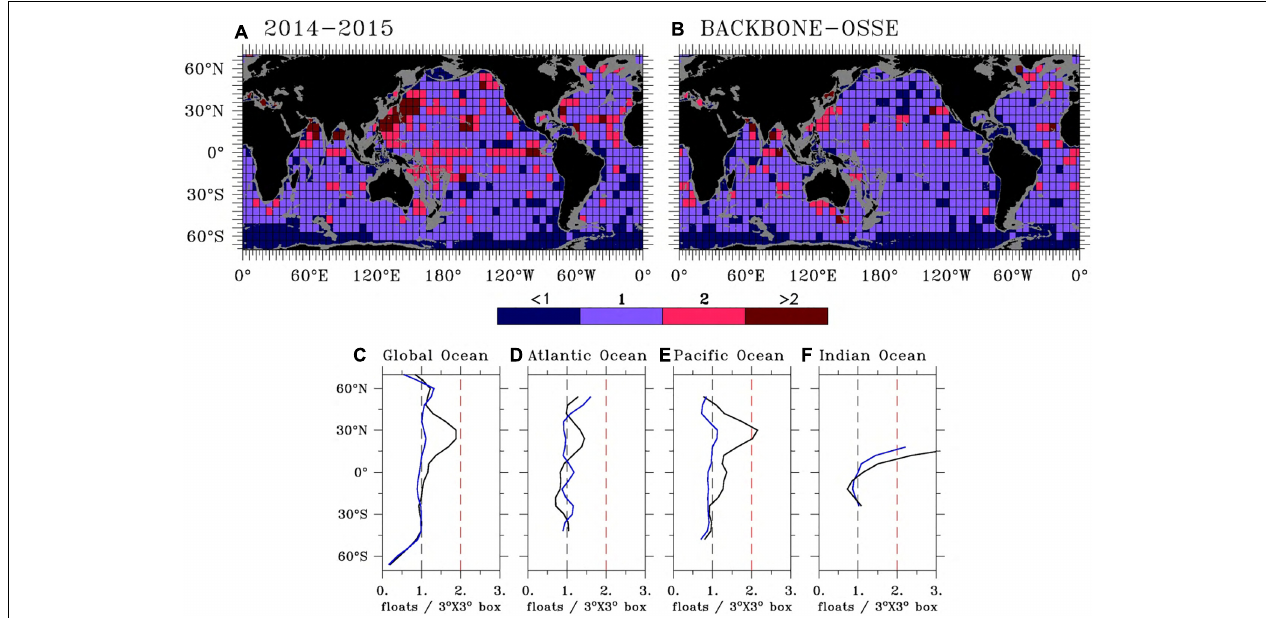
FIGURE 1 | Time-averaged number of floats per 6 ◦ × 6 ◦ box (A) from the CORA4.1 dataset for the period 2014–2015, and (B) from the synthetic BACKBONE Argo design for the period 2009–2010. Unit is equivalent float number per 3 ◦ × 3 ◦ box. In (C–F) , the zonally averaged number of floats is indicated for each basin, with (C) the global Ocean, (D) the Atlantic Ocean, (E) the Pacific Ocean, and (F) the Indian Ocean. The black and blue lines indicate the 2014–2015 CORA4.1 and the 2009–2010 synthetic BACKBONE quantities, respectively.